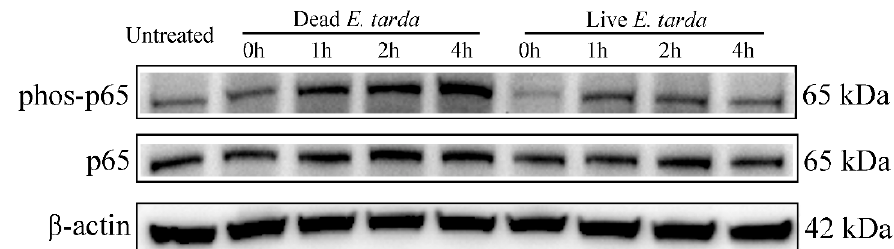
Figure 8. Effects of live and dead Edwardsiella tarda on NF- κ B p65 phosphorylation. RAW264.7 cells were infected with or without live or dead E. tarda for 2 h and then treated with 100 µg/mL